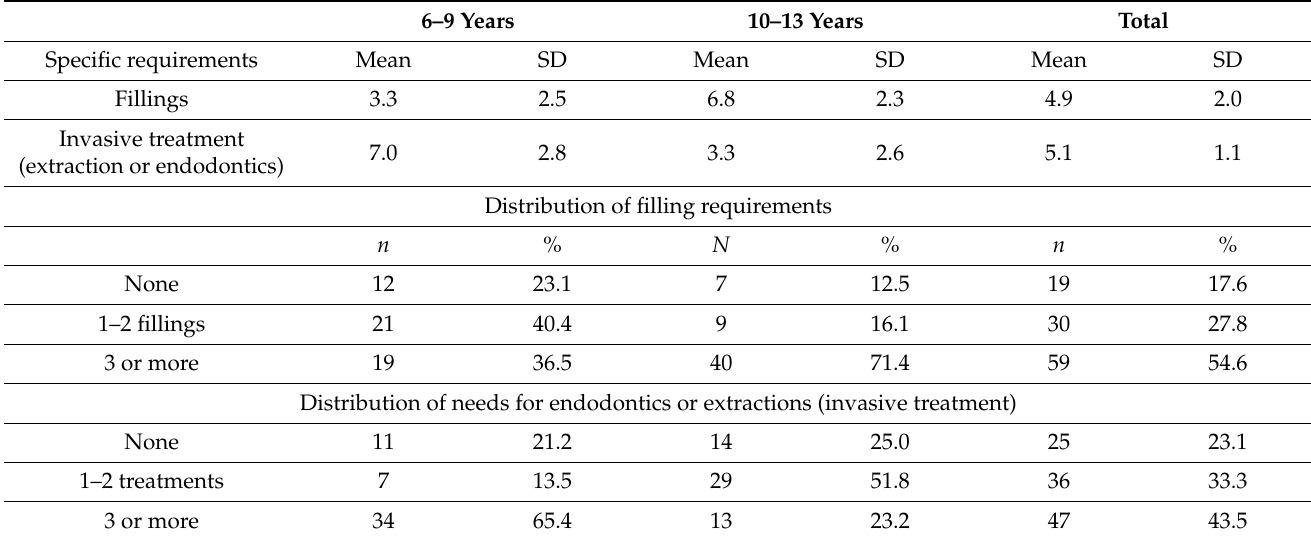
Table 3. Description of dental treatment needs according to age